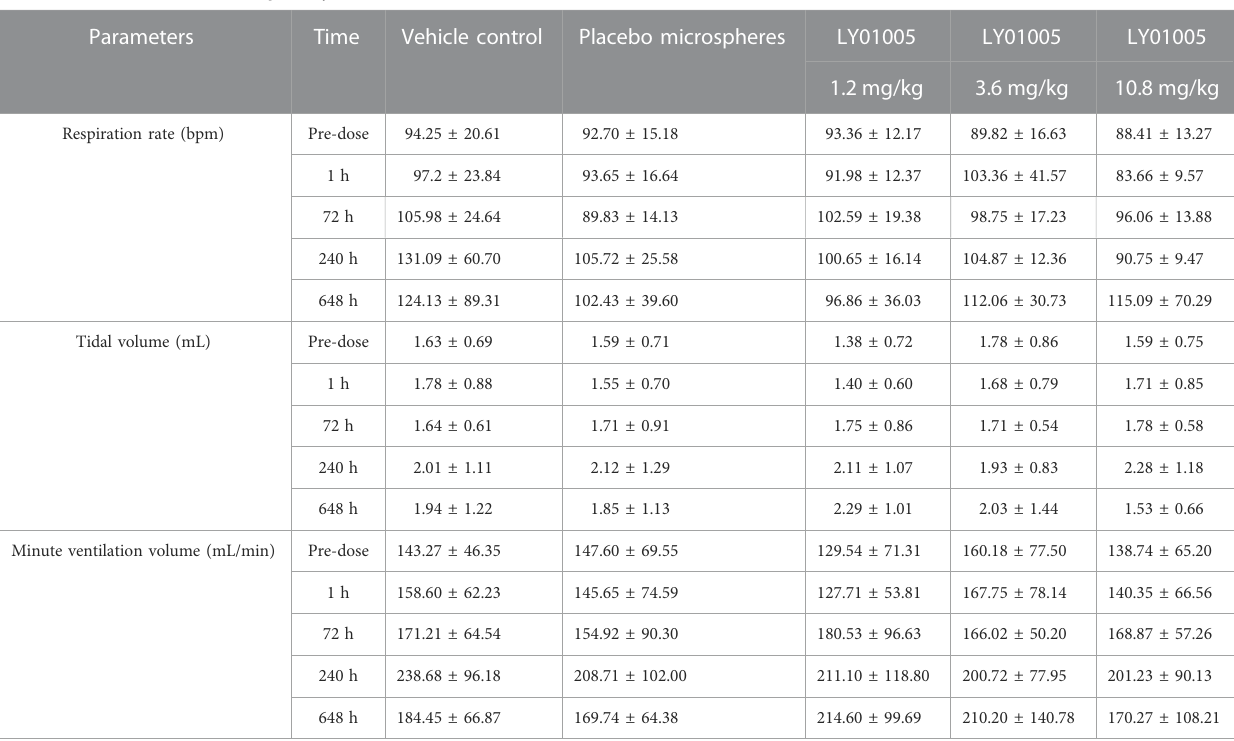
TABLE 1 Effects of LY01005 on respiratory functions of